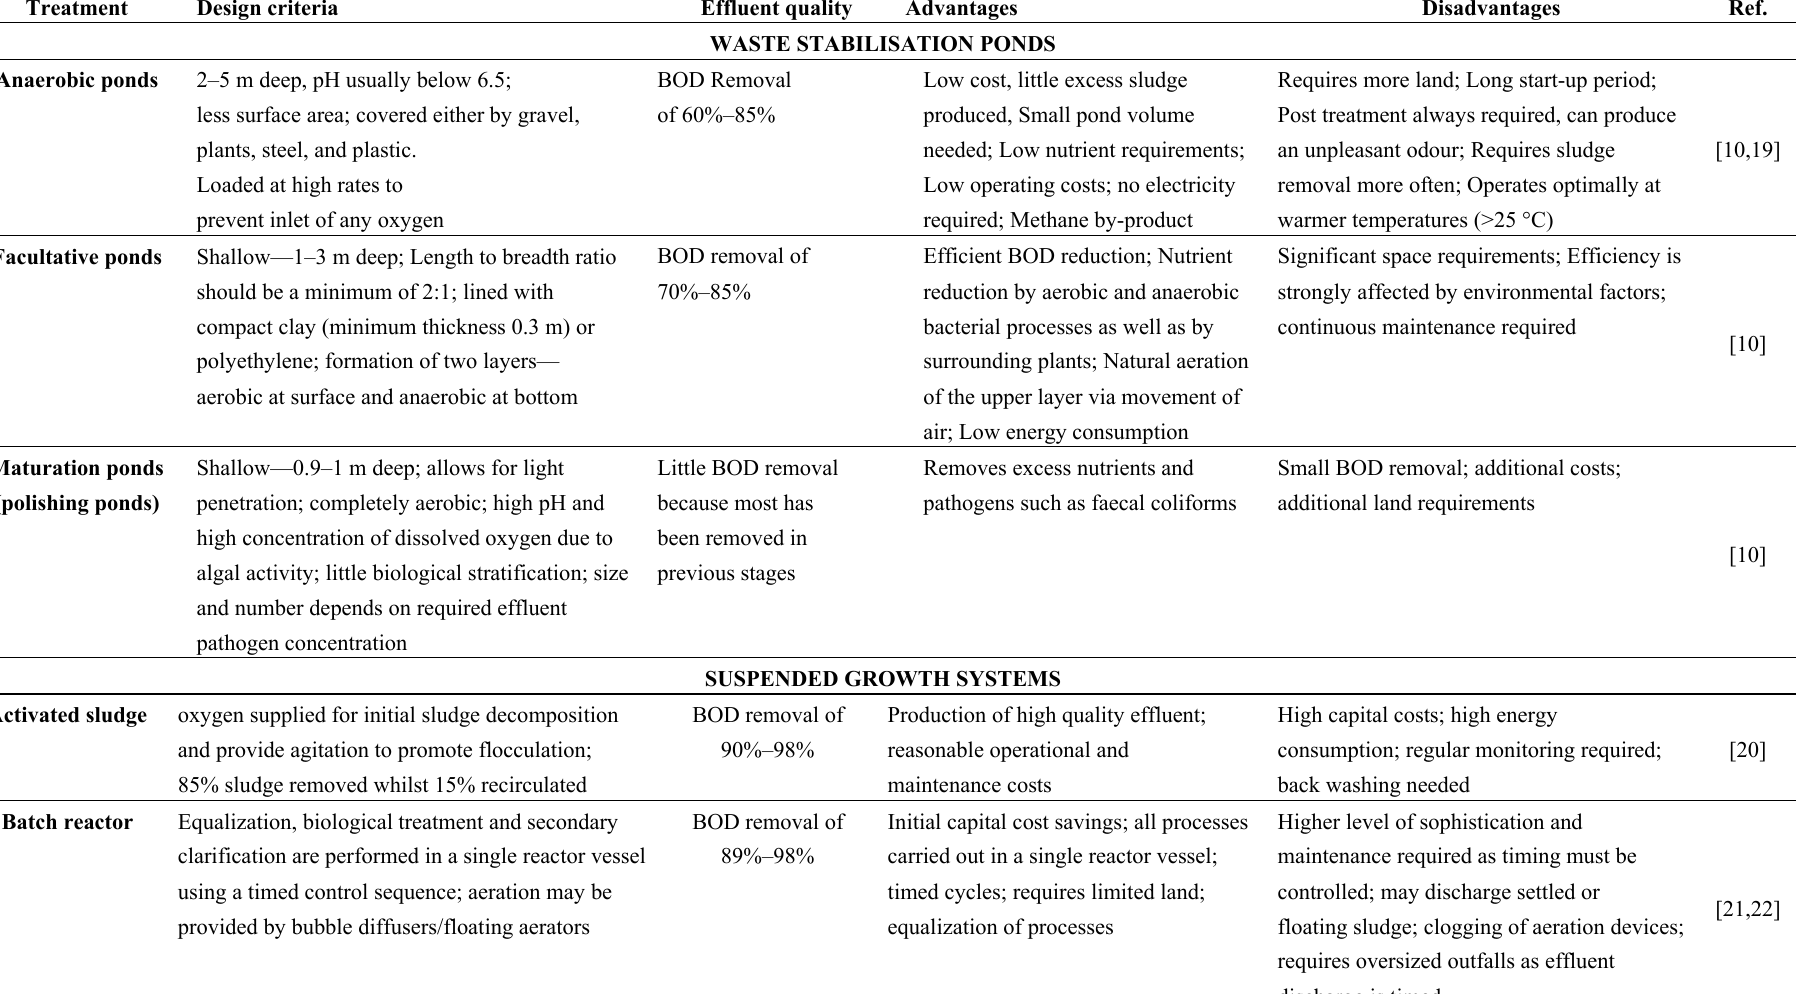
Table 1. Overview of various secondary treatment options